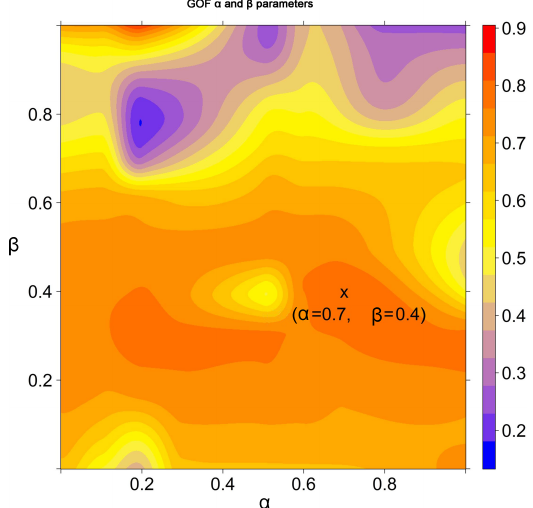
Figure 5. Calibration of flow partitioning ( α and β parameters in Fig. 2) between the ED2 and the ED2 + R reservoirs. The color bar indicates the NSE values of the simulated vs. the observed river flow values (0: very different; 1: very